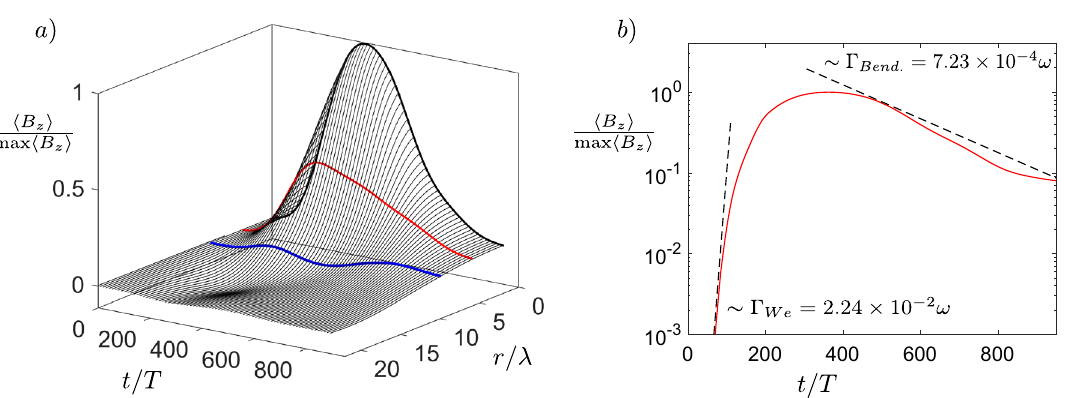
Figure 4. Temporal evolution of generated magnetic field. ( a ) Longitudinally averaged radial lineout of axial magnetic field with slices highlighted at radial distance r / (cid:31)